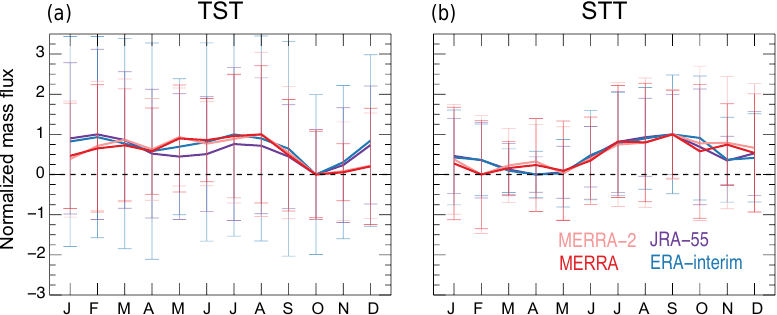
Figure 10. Annual cycles of (a) normalized TST and (b) normalized STT for the tropics from each reanalysis model. As in Fig. 9, the solid colored lines are the mean annual cycles and the colored error bars are plus/minus 1 standard deviation from the mean. STE from JRA-55 is shown by the purple lines, ERA-Interim by the blue lines, MERRA-2 by the light red lines, and MERRA by the dark red